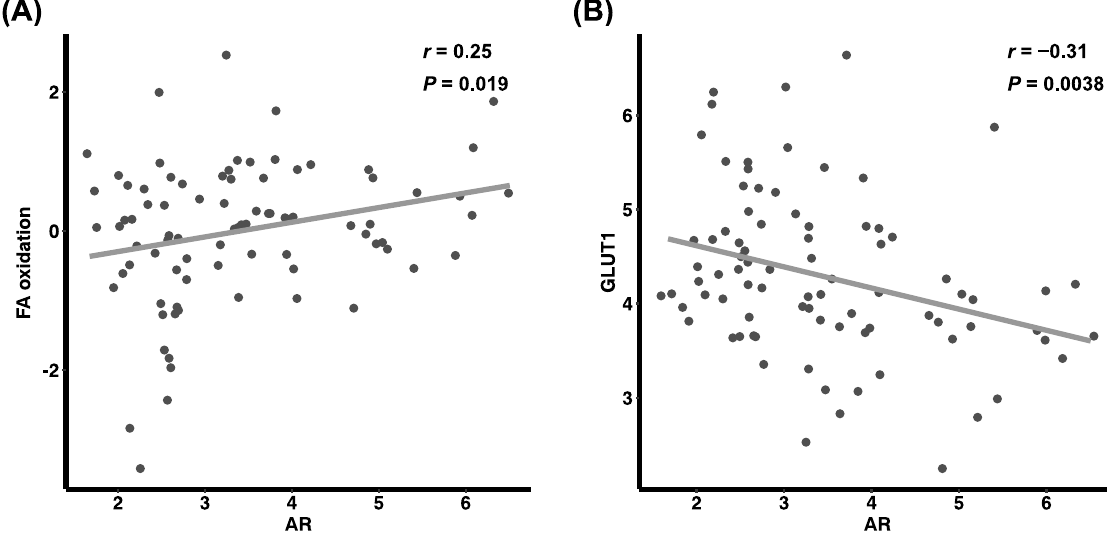
Fig 4. Correlations of AR with expression of FA β -oxidation-associated genes and GLUT1. AR expression show positive correlation with FA oxidation (A) and negative correlation with GLUT1 expression (B). AR, expression level of androgen receptor gene; FA, fatty acid; FA oxidation, gene set enrichment score of FA β -oxidation-associated genes; GLUT1, expression level of GLUT1 (SLC2A1) gene.